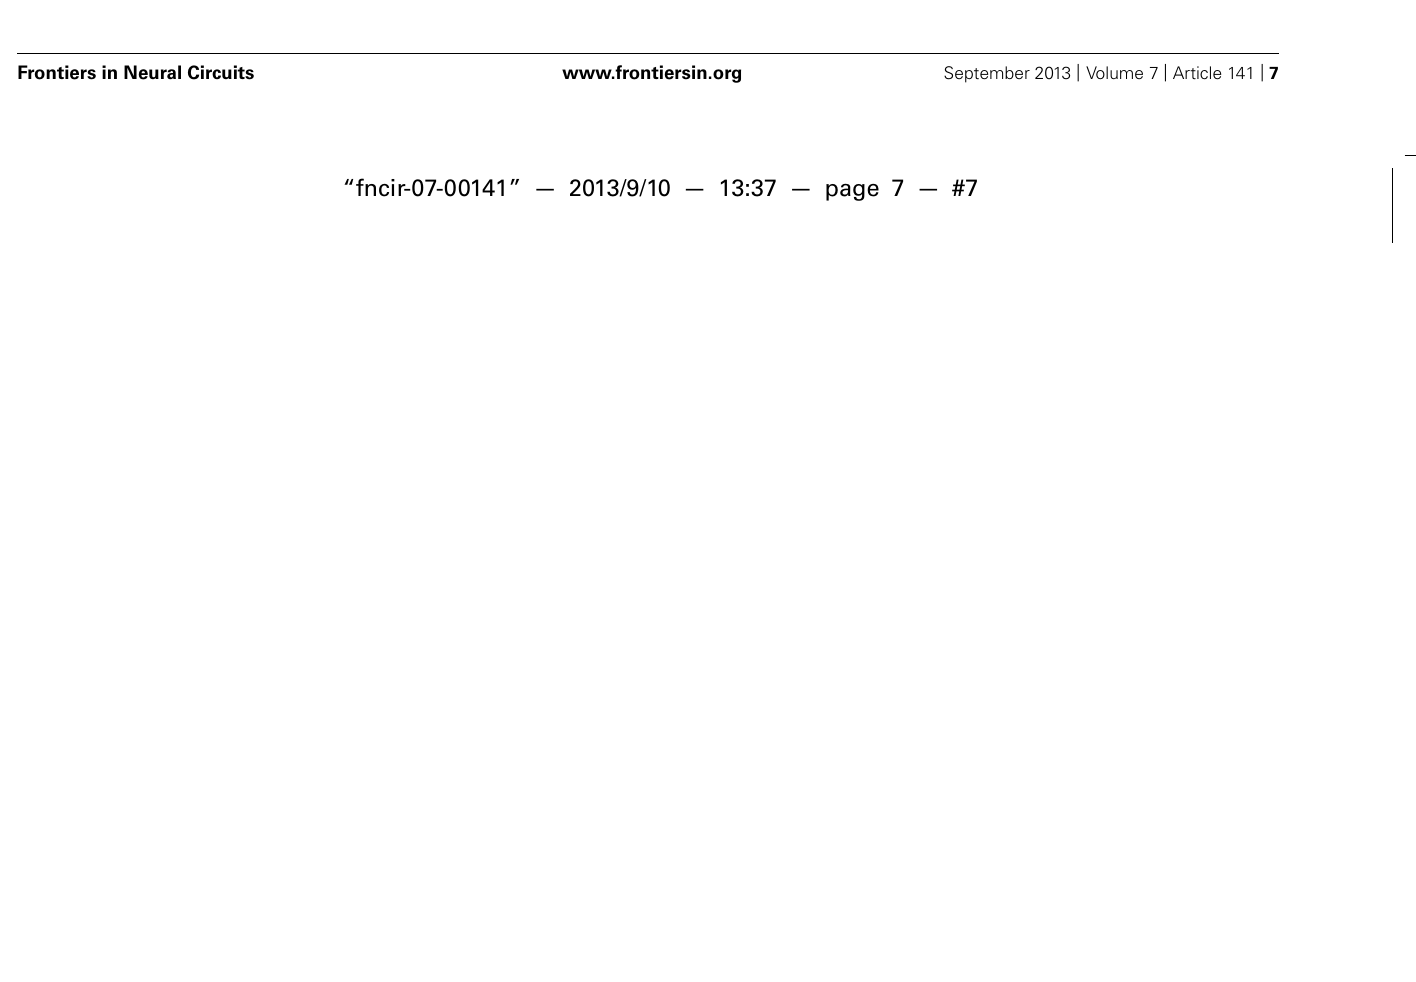
t = 0 is the beginning of bursts as detected in the field potential. Bin widths were 10 ms up to 200 ms post-event and 25 ms further into the bursts. (D) AUROC (black line) and bootstrapped 95% confidence intervals (gray area) for the bin-by-bin comparison of the PETHs in (C) . (E) Same as (D) , but for all concentrations of NO-711 tested. Confidence intervals were omitted for